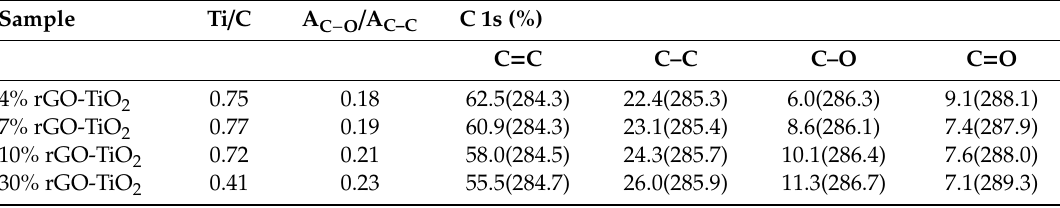
Table 7. Ti / C, A C-O / A C-C ratios, species percentages, and bond energies (in brackets, eV) obtained by XPS analysis.